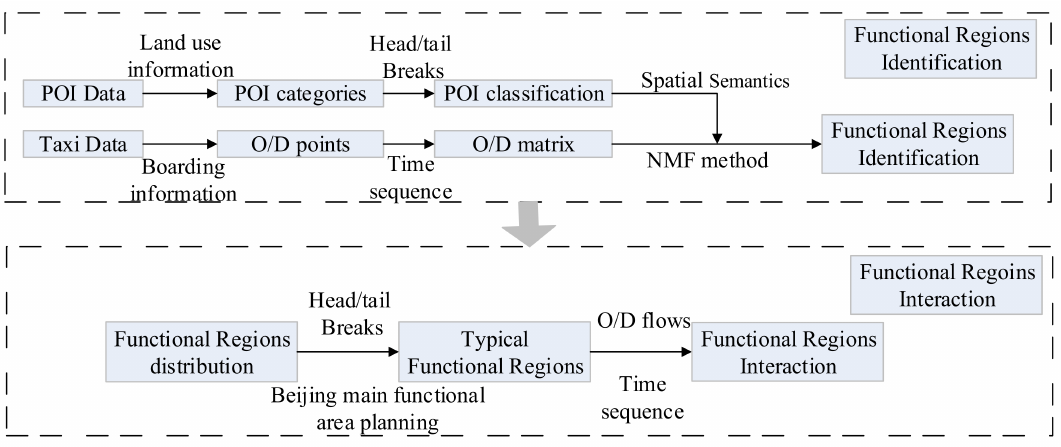
Figure 1. Flowchart of the proposed